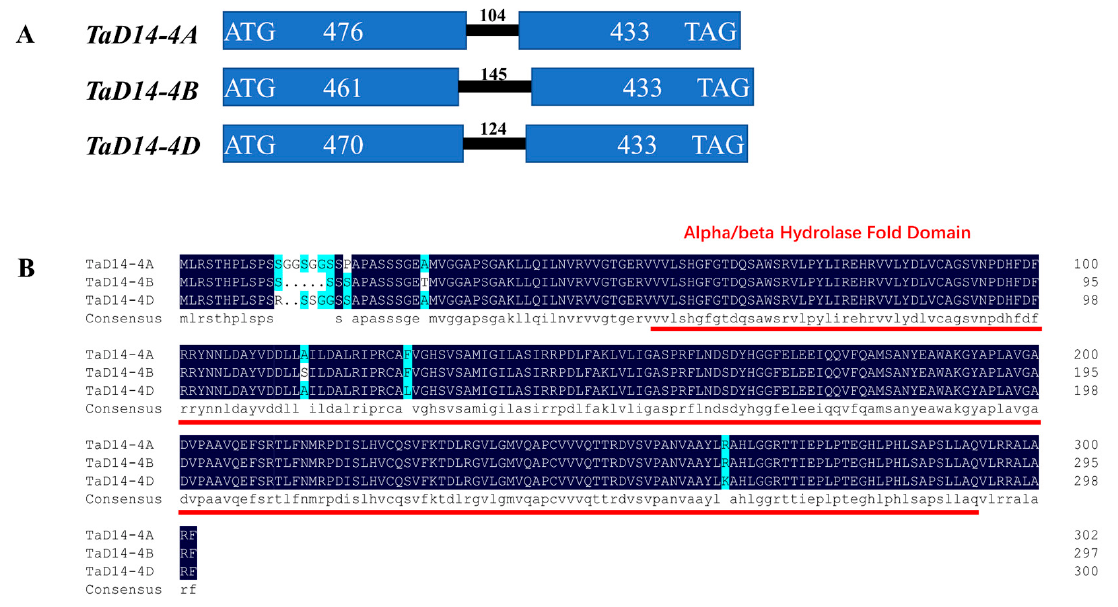
Figure 1. Structures of TaD14 homoeologous genes and amino acid sequence alignment. ( A ) Gene structures of TaD14-4A , TaD14-4B , and TaD14-4D . The blue rectangles represent exons, the solid black line between exons represents introns, and the number above represents the number of bases. ( B ) The amino acid sequence alignment of TaD14 proteins in Chinese Spring. The predicted α / β -hydrolase fold domain is indicated by the red line.